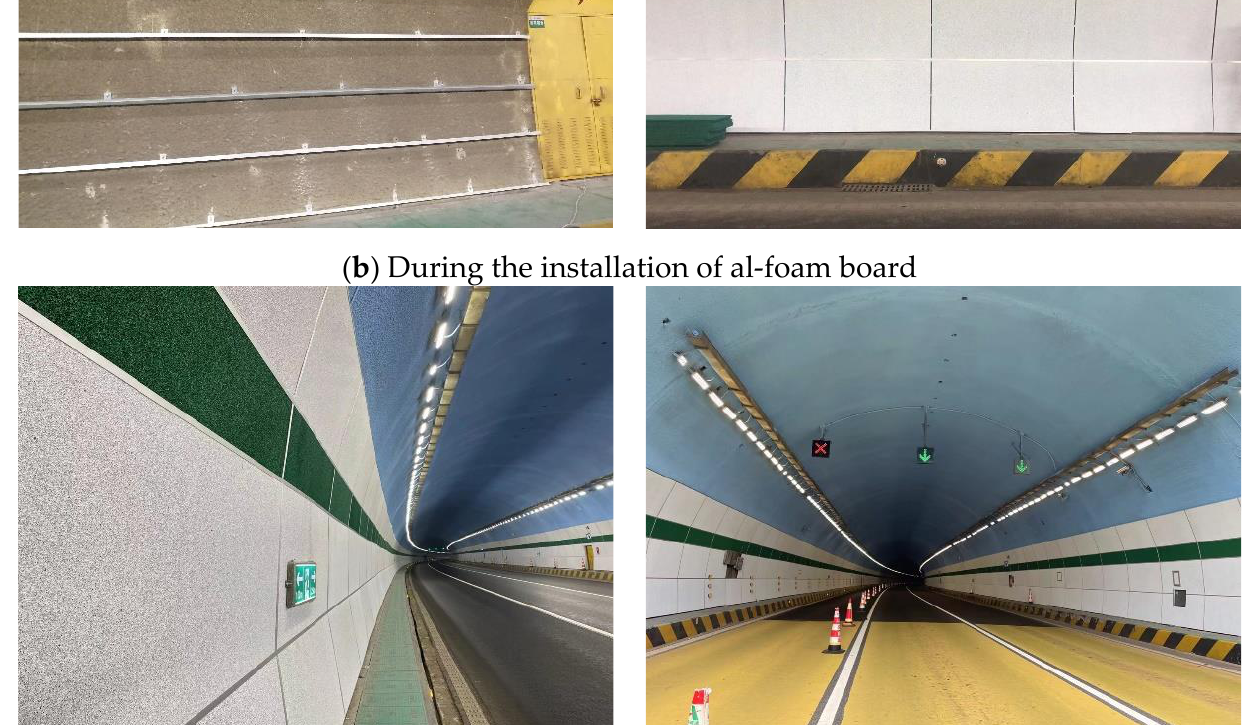
Figure 12. Comparison of the effect before and after installation of the al-foam board.